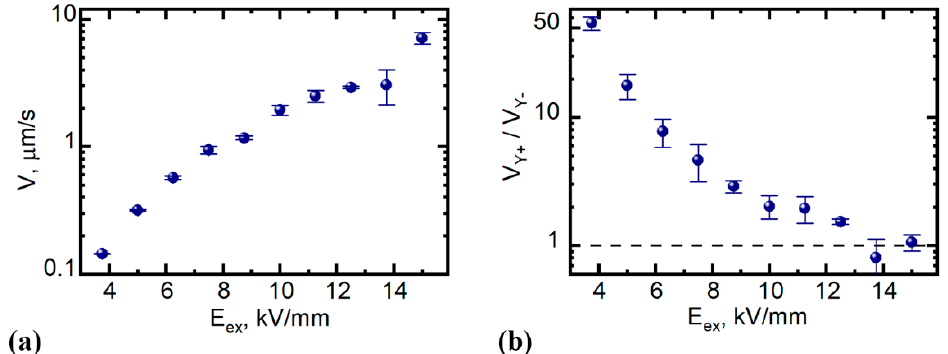
Figure 7. Field dependences of ( a ) fast Y + wall velocity and ( b ) ratio of fast Y + to slow Y- wall velocities.